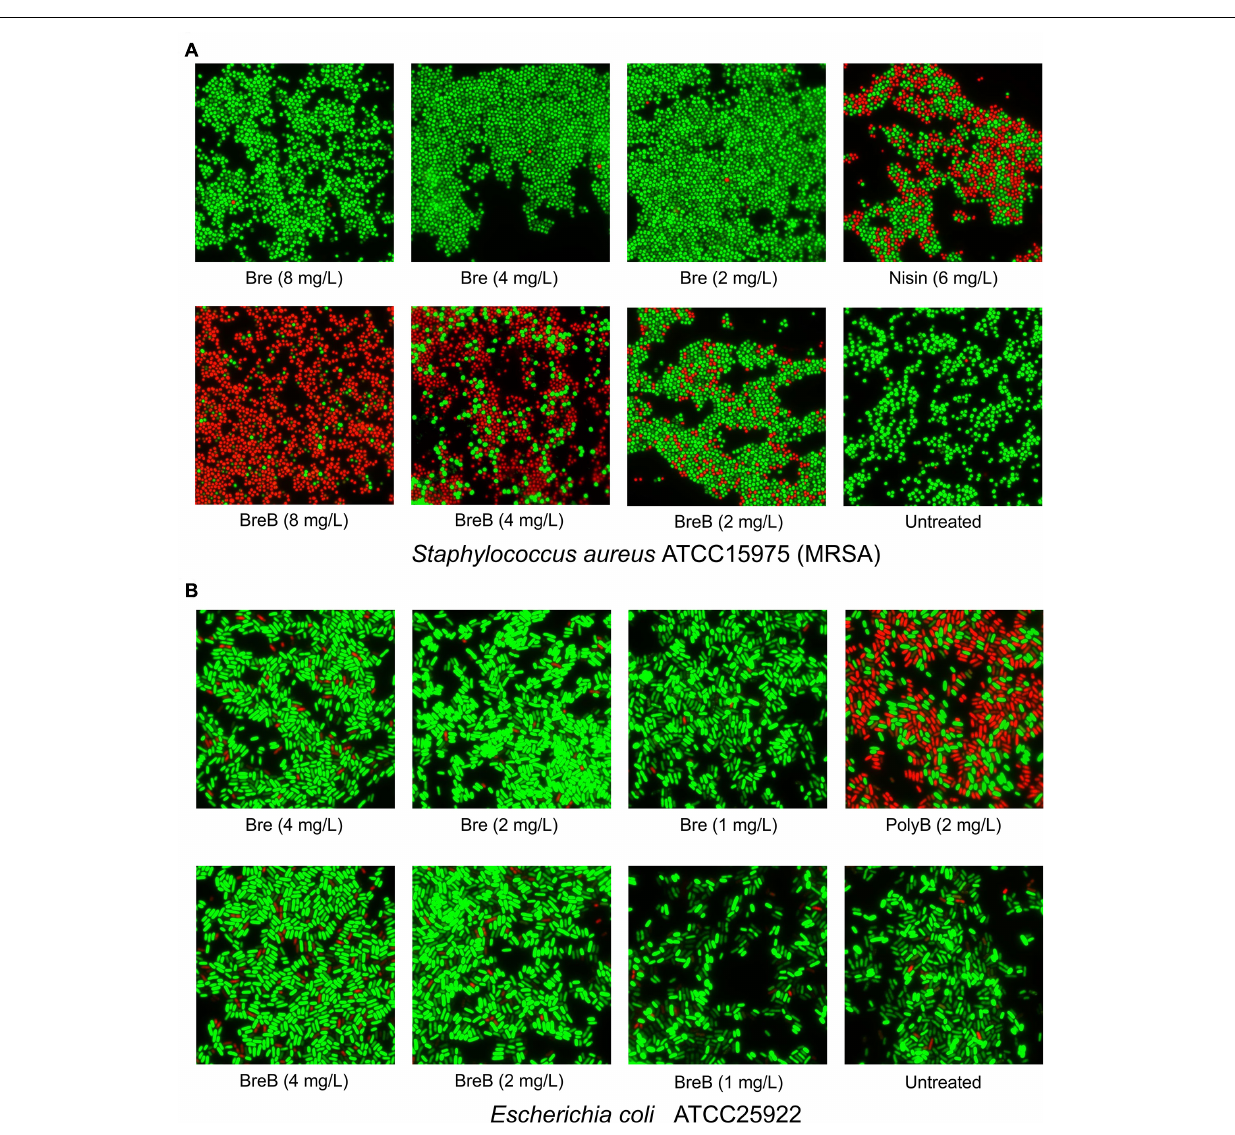
FIGURE 3 | BrevicidineB acts as a potent antibiotic against Gram-positive bacteria by disruption of the cellular membrane. (A) Fluorescence microscopy image of Staphylococcus aureus cells after being exposed to nisin (6 mg/L; 1 × MIC), brevicidine (8 mg/L, 4 mg/L, or 2 mg/L), and brevicidineB [8 mg/L (2 × MIC), 4 mg/L (1 × MIC) or 2 mg/L (0.5 × MIC)] for 15 min. (B) Fluorescence microscopy image of E. coli cells after being exposed to polymyxin B (2 mg/L; 1 × MIC), brevicidine [4 mg/L (2 × MIC), 2 mg/L (1 × MIC) or 1 mg/L (0.5 × MIC)], and brevicidineB [4 mg/L (2 × MIC), 2 mg/L (1 × MIC), or 1 mg/L (0.5 × MIC)] for 15 min. Green denotes a cell with an intact membrane, whereas red denotes a cell with a compromised